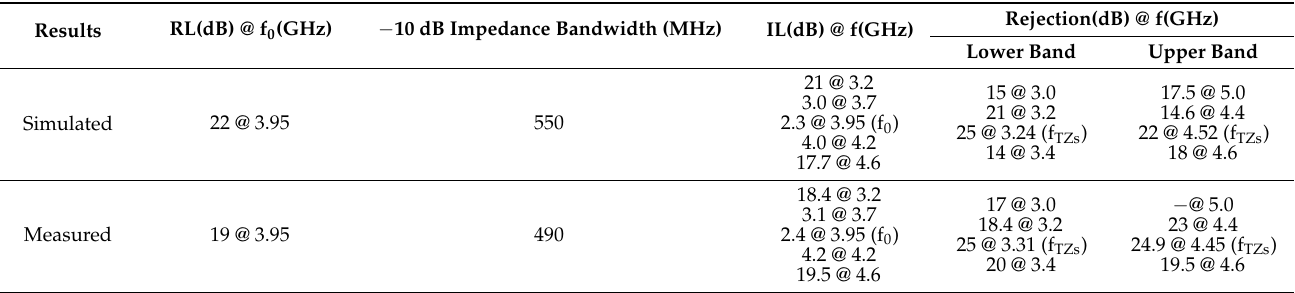
Table 1. Simulation and measurement result comparison.